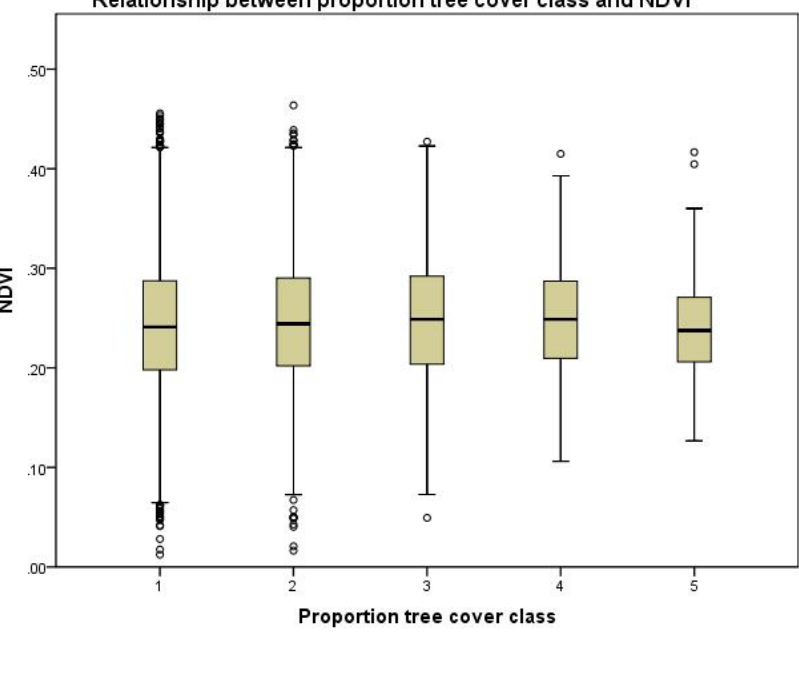
Figure 9. Boxplots of the NDVI values for each tree coverage class (1–5) as determined by proportion tree cover per Landsat TM 30 × 30 m